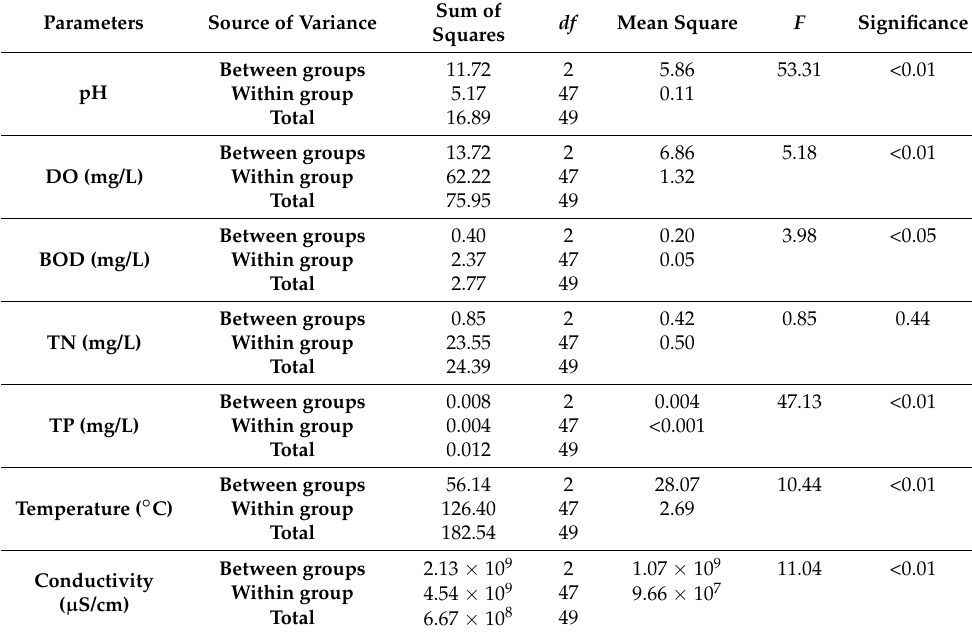
Table A6. One-way ANOVA results in accordance with different regions.